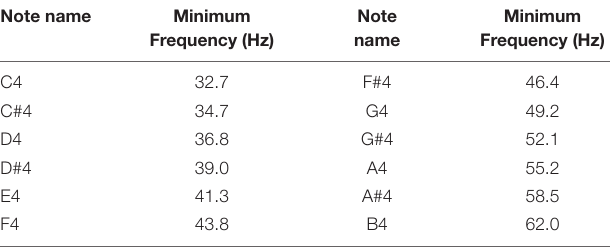
TABLE 1 | Minimum frequencies (in Hz) of Shepard tones.